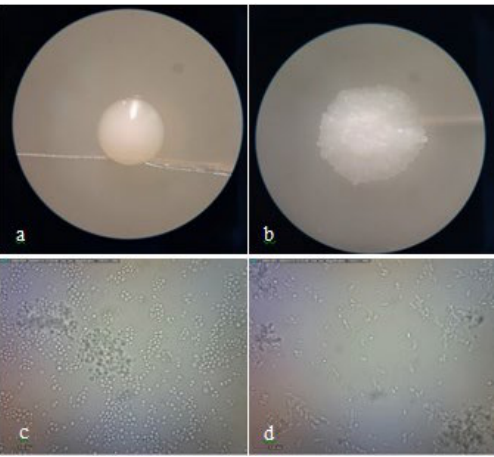
Fig. 4. The presence of clear zone appeared after Lugol drops by isolates DU4.2 (a) and isolates DU4.22 (b) incubated on YPSA medium at 30°C for 72 h.